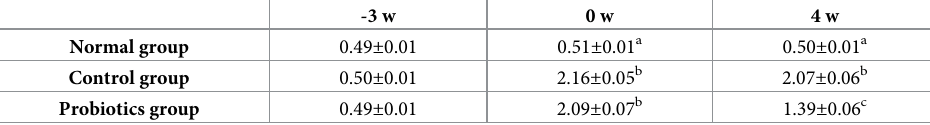
Table 12. The effect of probiotics treatment on serum creatinine concentration (mg/dL) in adenine-induced CKD rats. -3 w 0 w 4 w Normal group 0.49 ± 0.01 0.51 ± 0.01 a 0.50 ± 0.01 a Control group 0.50 ± 0.01 1.39 ± 0.06 c The normal group (N = 20) was untreated. The control group (N = 20) and the probiotics group (N = 20) received adenine orally from Week -3 to Week 0 to induce CKD. The control group received PBS orally from Week 0 to Week 4. The probiotics group received probiotics dissolved in PBS orally from Week 0 to Week 4. When the Bartlett test were any differences in the means of the three groups. Then, the significance of the intergroup mean differences was examined using Bonferroni’s test. A non-parametric comparison using the Kruskal–Wallis H test was performed if a deviation from variance homogeneity was significant. The level of significance was set at p < 0.05. Data are presented